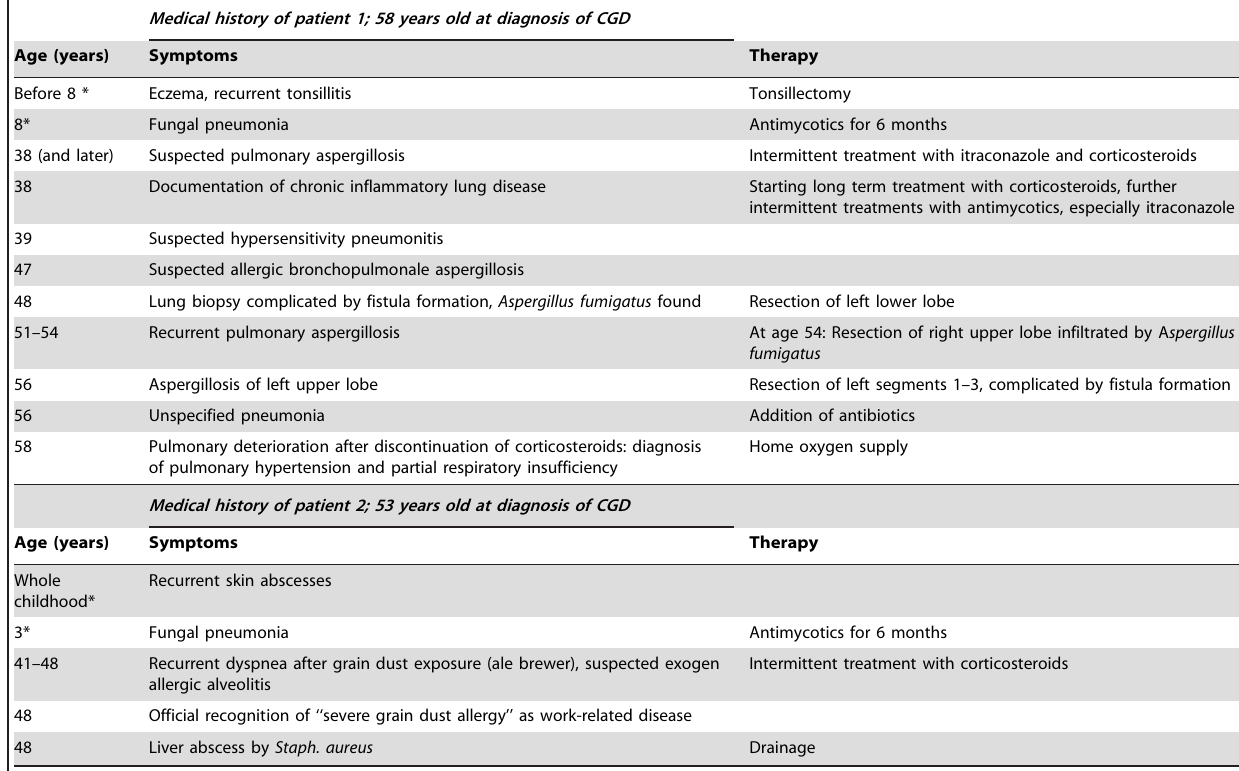
Table 1. Overview over medical